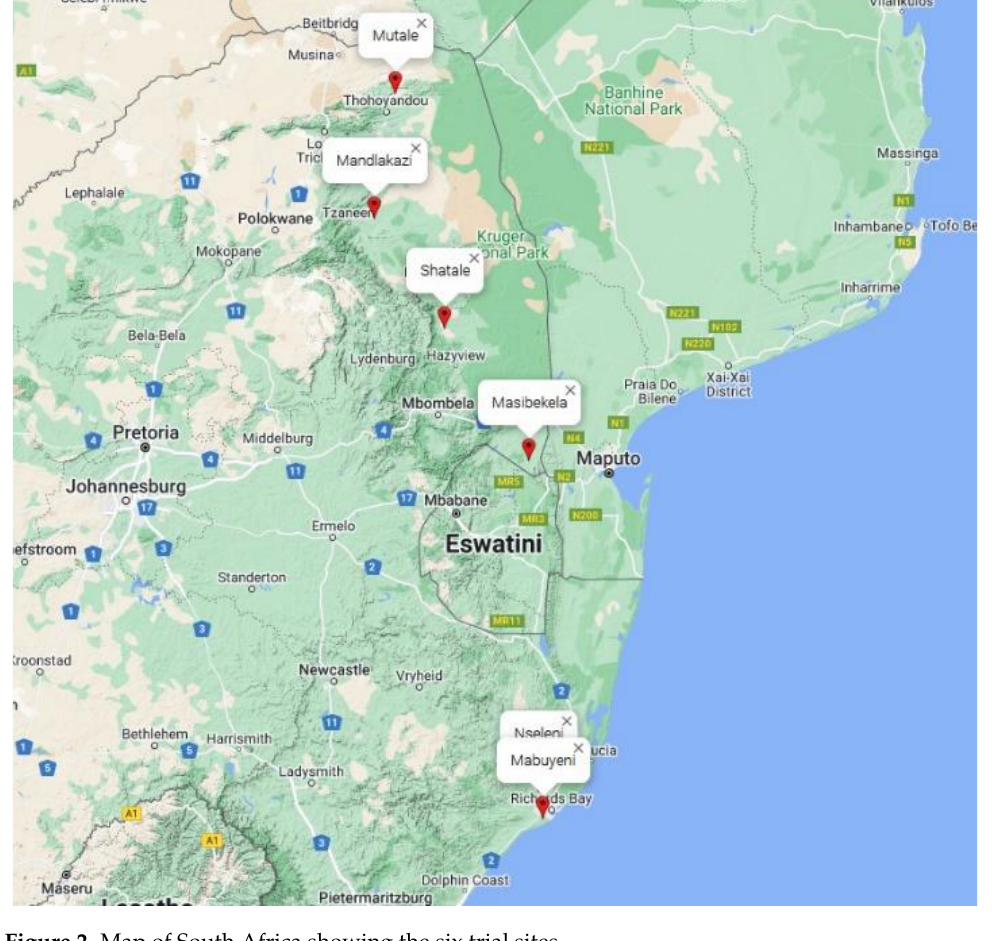
Figure 2. Map of South Africa showing the six trial sites.